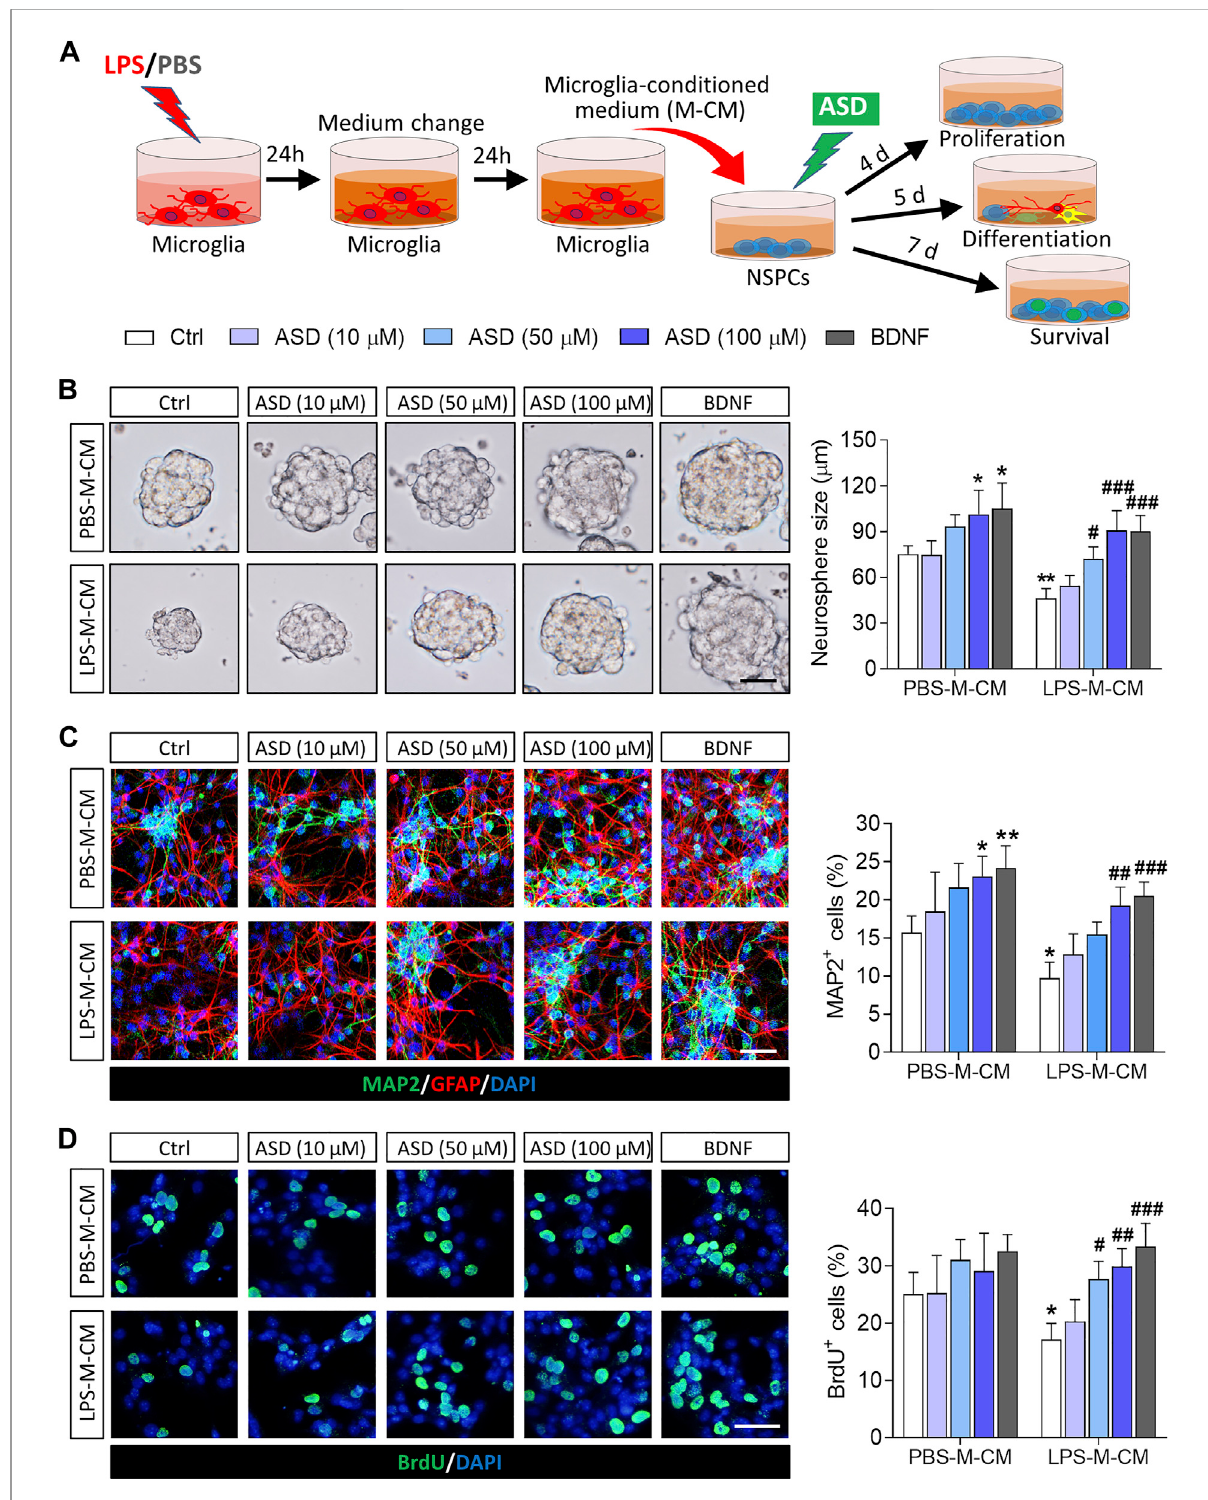
FIGURE 1 Effects of ASD on NSPC proliferation, survival and neuronal differentiation in the presence or absence of a microglia-mediated in fl ammatory niche. (A) , Scheme describing the experimental evaluation of the effects of akebia saponin D (ASD) on survival of neurospheres in the presence or absence of an in fl ammatory niche. Microglia were treated with phosphate-buffered saline (PBS) or lipopolysaccharide (LPS) for 24 h, and the microglia-conditioned medium (M-CM) was collected. Neural stem/precursor cells (NSPCs) were treated with different concentrations of ASD